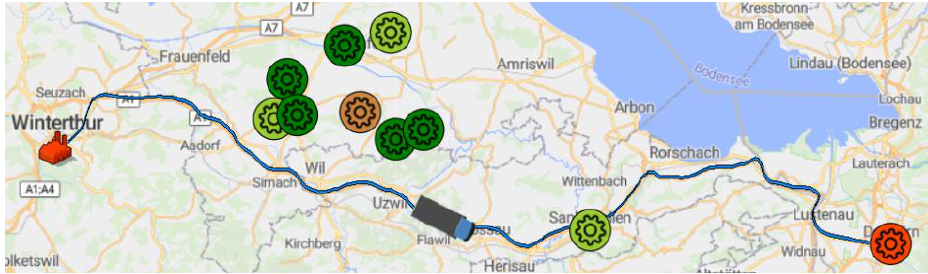
Fig. 3. GIS-Map with provider (red factory) and customers (cogwheels) in which the service team (lorry) is on the way to a malfunctioning machine (red cogwheel) (hypothetical